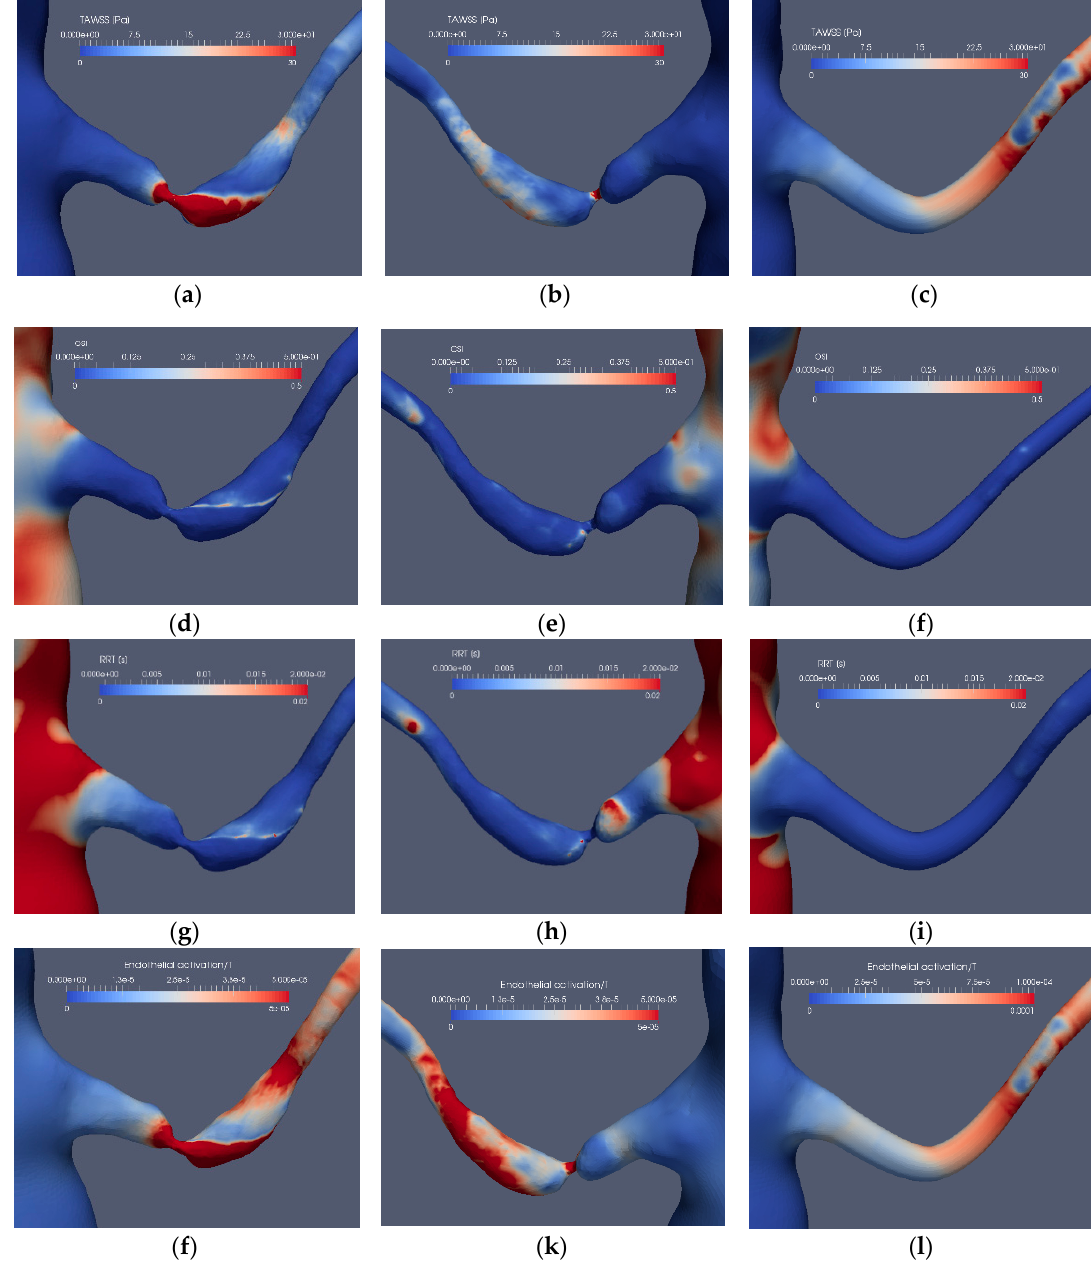
Figure 9. The stenosis indicators for Case1.1 (stenoted) and Case1.3 (reconstructed and smoothed): The left and right frames show the left renal artery from the anterior view, whereas the mid-frames show the same artery from a posterior view for TAWSS ( a – c ), OSI ( d – f ), RRT ( g – i ) and EAI ( j – l ).